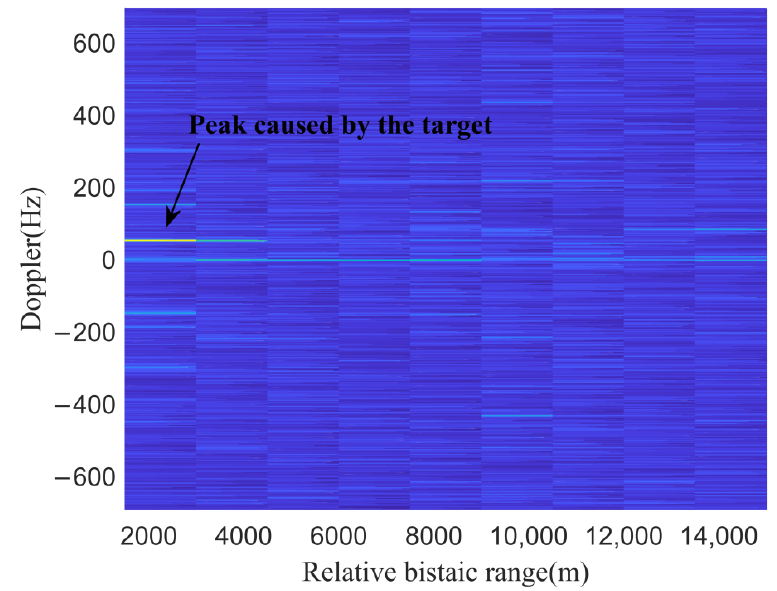
Figure 21. RDCC after eliminating the strong interference in Figure 20.